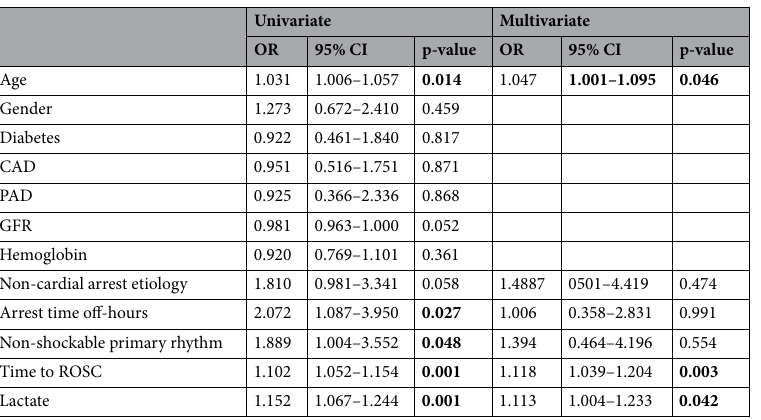
Table 4. SaT group: Regression analysis for hospital mortality after IHCA. Significant values are in bold. IHCA in-hospital cardiac arrest, LaG load-and-go, SaT stay-and-treat, IHCA intra-hospital cardiac arrest, OR odds ratio, CI confidence interval, GFR glomerular fraction rate, CPR cardiopulmonary resuscitation, CAD coronary artery disease, PAD peripheral arterial disease, ROSC return of spontaneous